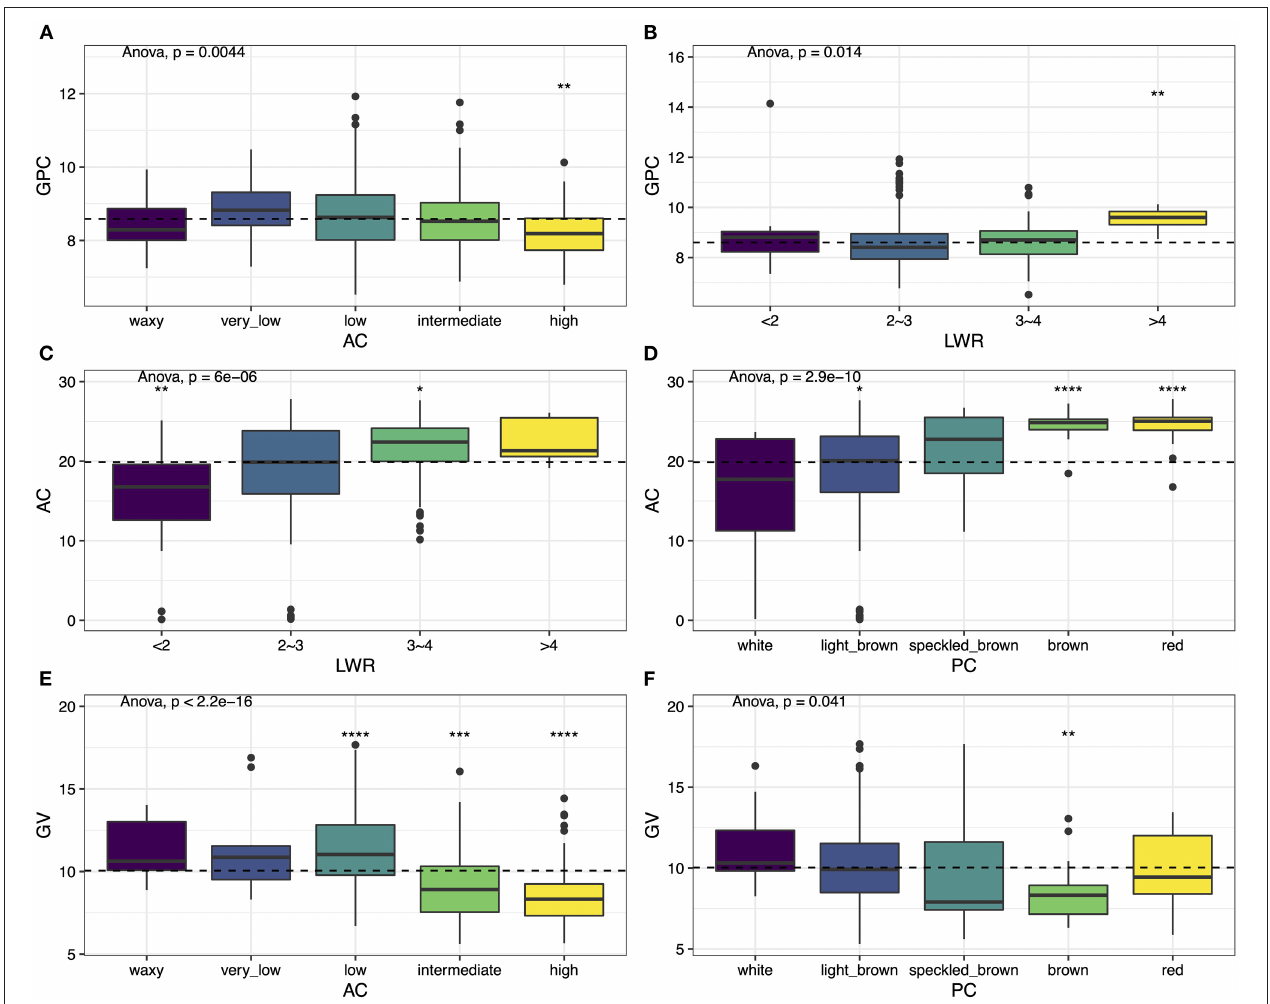
FIGURE 3 | Phenotypic variation among six traits. (A) GPC vs. AC, (B) GPC vs. LWR, (C) AC vs. LWR, (D) AC vs. PC, (E) GV vs. AC, and (F) GV vs. PC. Box plots show the distribution of the traits in subgroups. Whiskers represent 1.5 times the interquartile of the data. The upper and lower edge of the box presents the interquartile range of the data. The thick black bar in the center represents the median of the data. The one-way ANOVA test is used to determine whether there are any statistically significant differences between the subgroups, and the p -value is shown on the left corner of each figure. The total population acts as a reference group, and each subgroup is compared with the reference group. Different symbols above each subgroup indicate significant differences: * p < 0.05, ** p < 0.01, *** p < 0.001, and **** p < 0.0001. The dashed black line represents the mean value of the whole